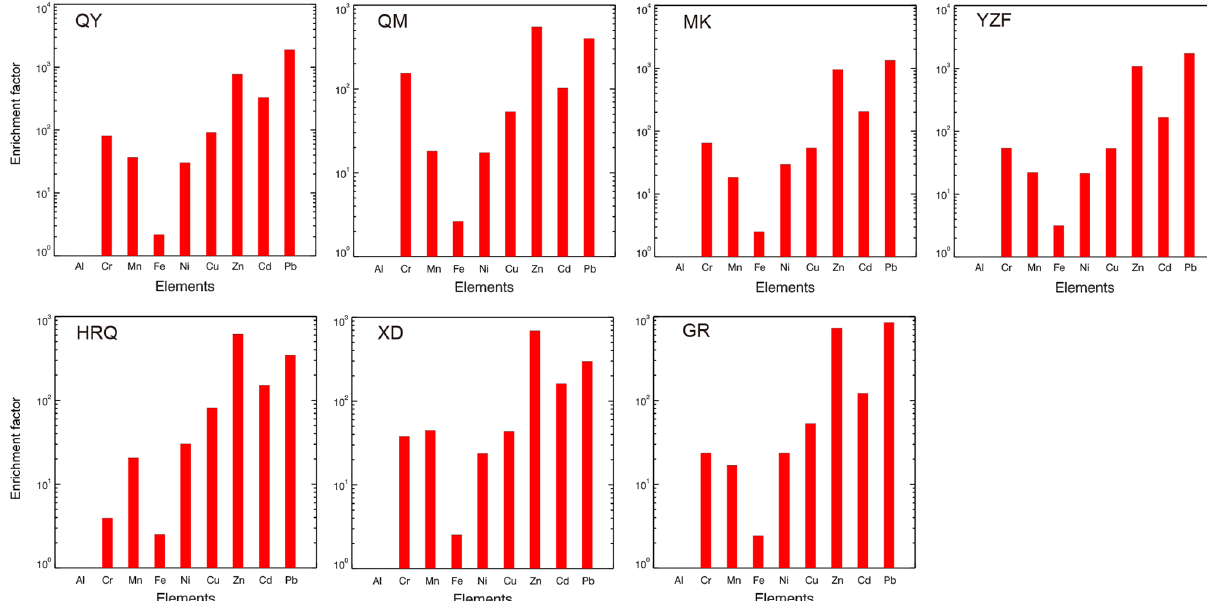
Figure 8. The average enrichment factors of trace metals in surface-ice samples from each